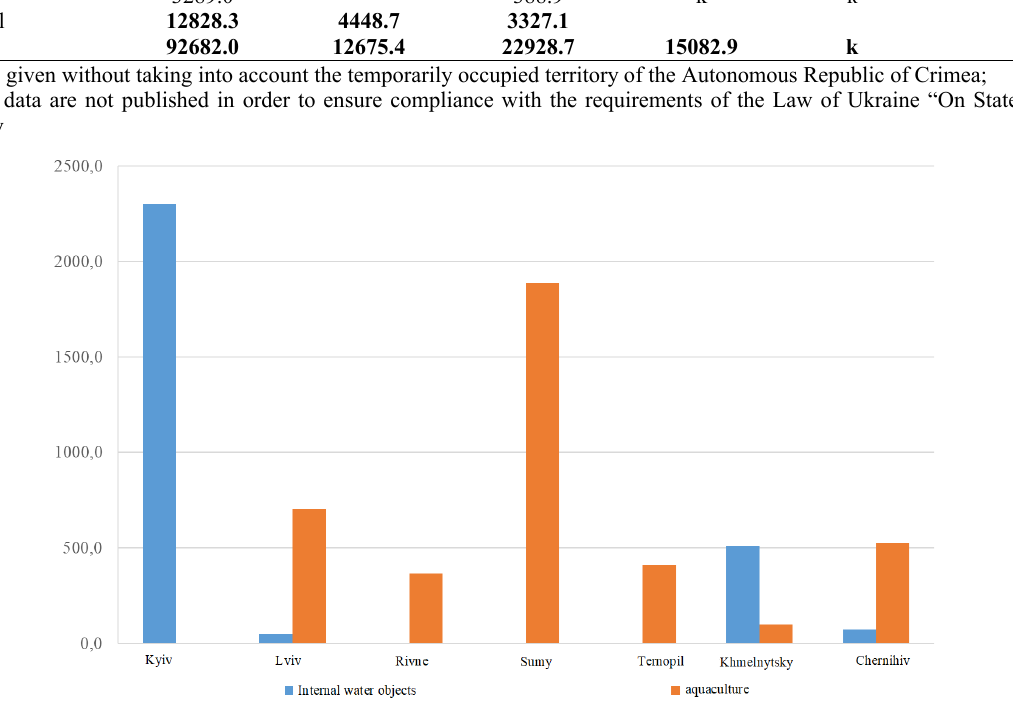
Fig. 3. Extraction of aquatic organisms in inland water bodies and aquaculture of the III fish-water zone for the territory